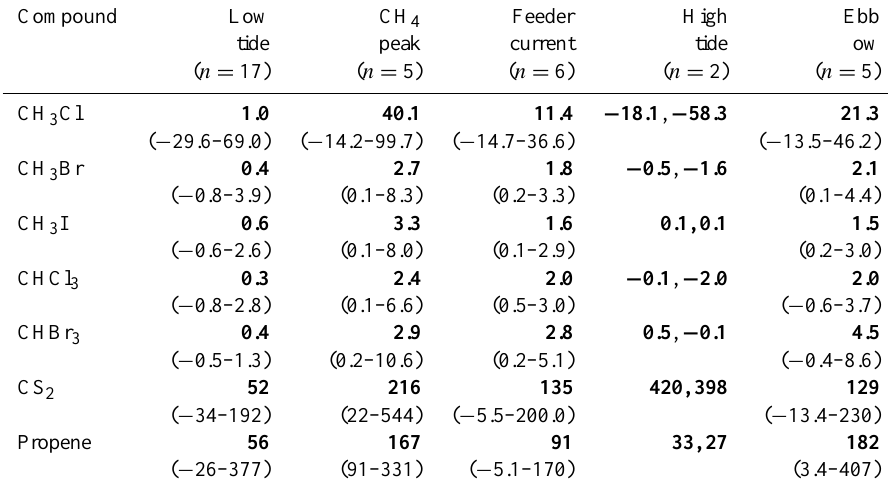
Table 2. Mean trace gas fluxes (bold) obtained from seagrass meadows along the tidal cycle. Fluxes are given in nmolm − 2 h − 1 . Numbers in parentheses are the range of fluxes. Fluxes during high tide are given as single values. Further details on CH 3 Cl, CH 3 Br, CH 3 I and CHBr 3 are given in Weinberg et al. (2015). By definition, emission fluxes are positive and deposition fluxes are